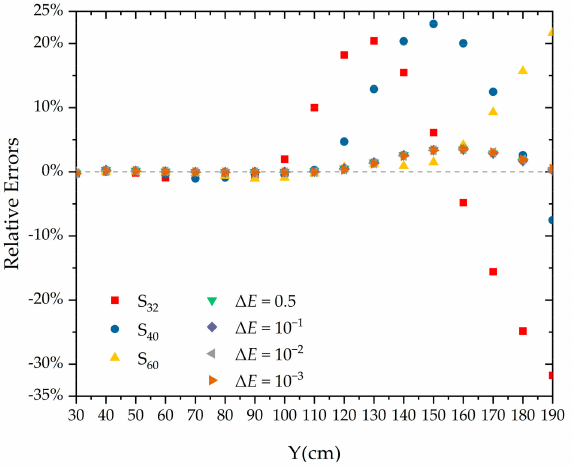
Figure 5. Relative errors of key points for the neutron streaming shielding